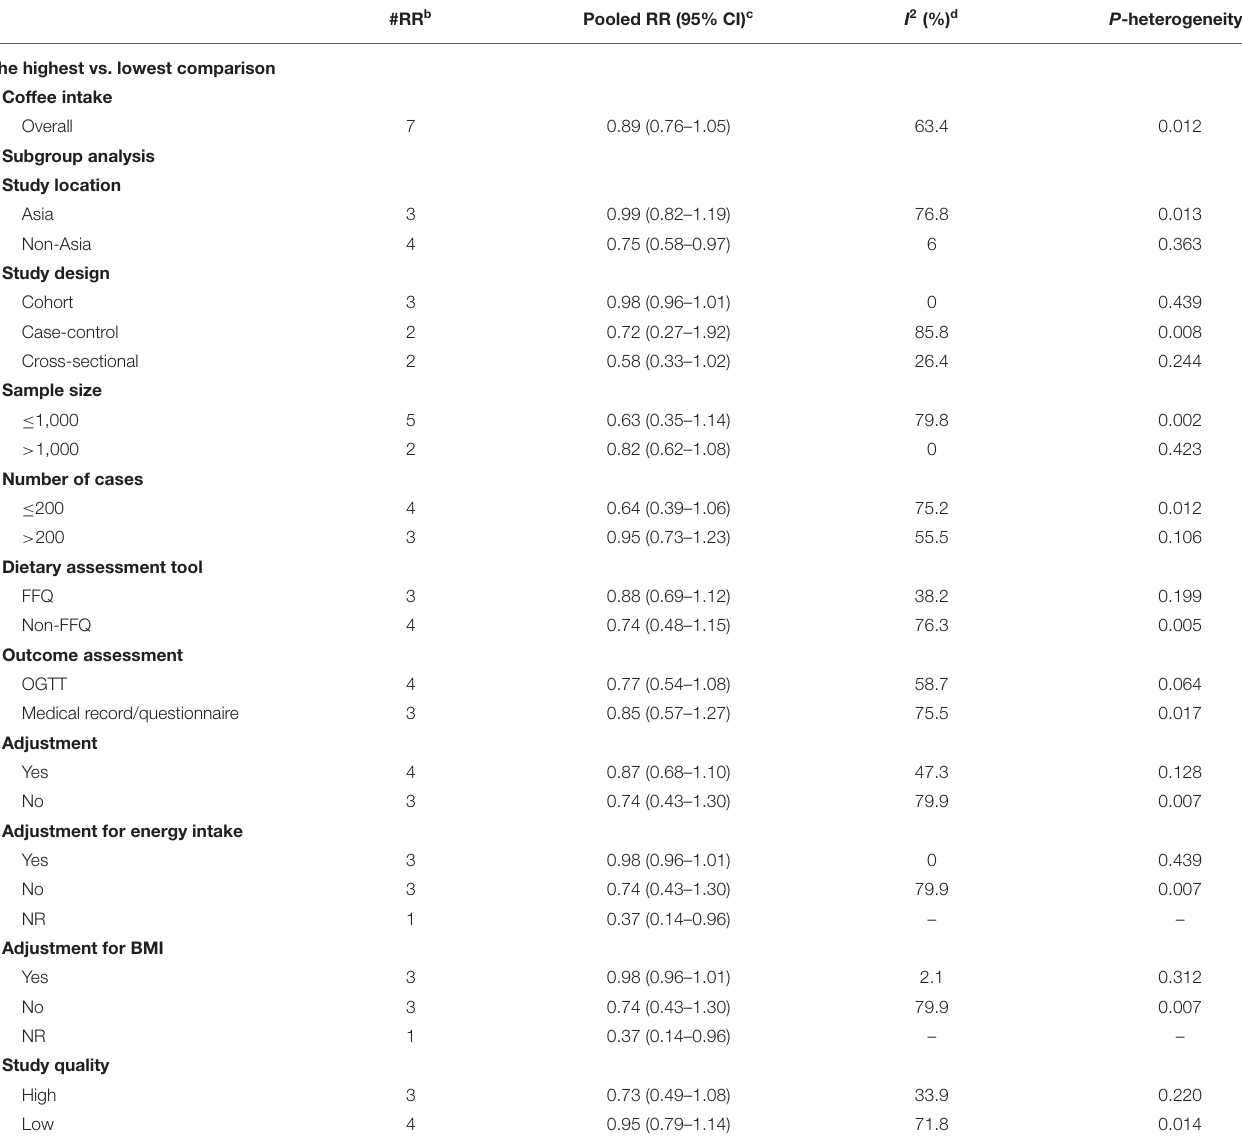
TABLE 2 | Summary risk estimates for the association between coffee consumption and risk gestational diabetes mellitus in subgroup analysis a